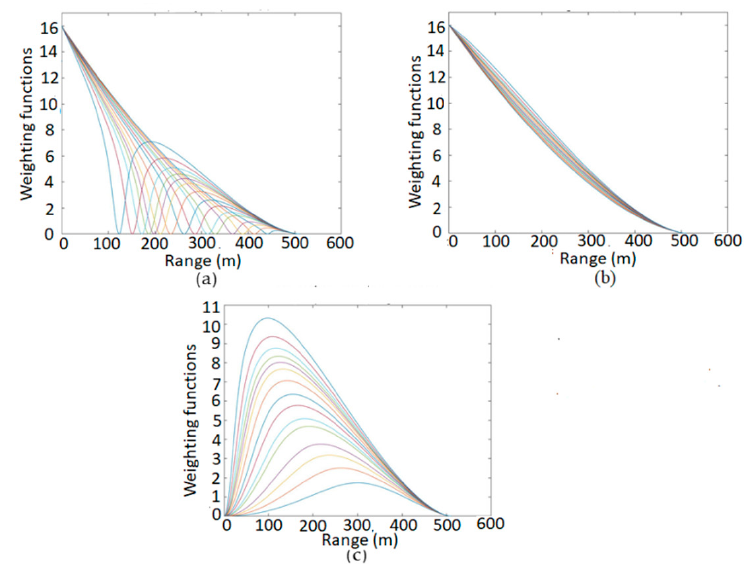
Figure 2. Path weighting functions of differential tilt variance for 15 different source separations in the long-range experiment. The weighting functions are for the imaging path geometries shown in Figure 1. ( a ) Sensing paths cross; ( b ) Sensing paths do not cross; ( c ) Sensing at a single aperture.